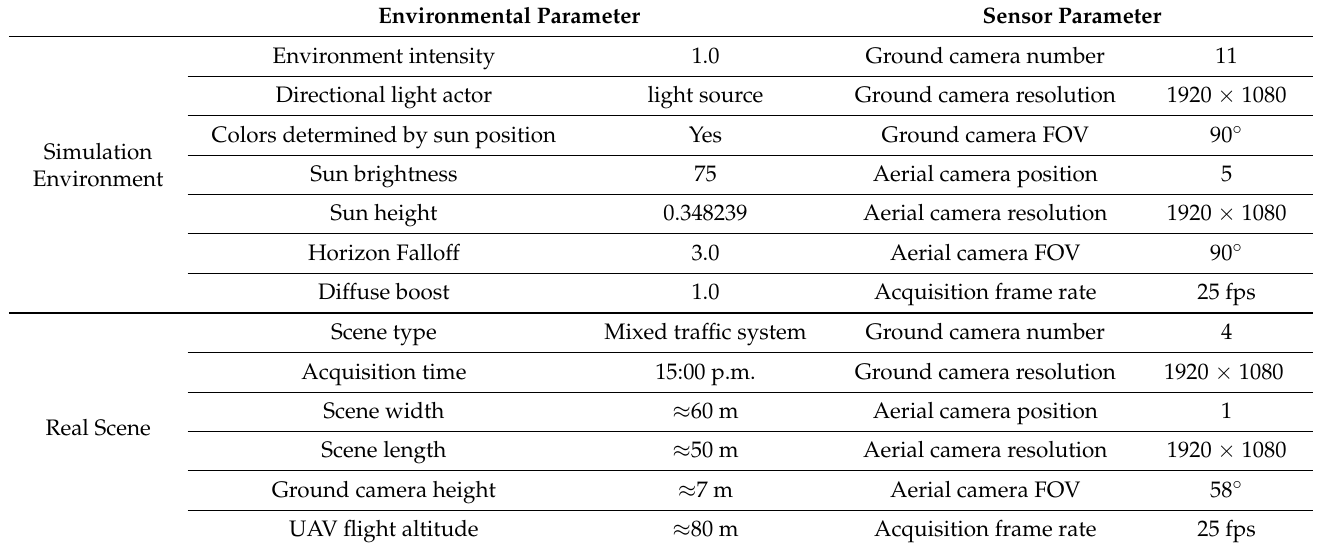
Table 2. The parameter settings to generate database in simulation environment and real scene. Environmental